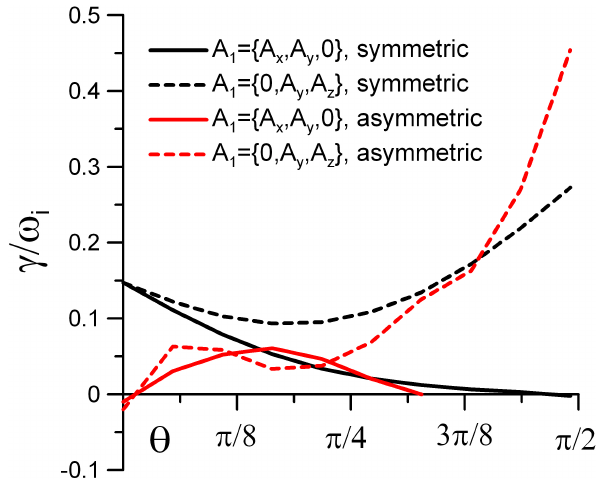
Fig. 1. Sketch of eigenmodes in the CS.